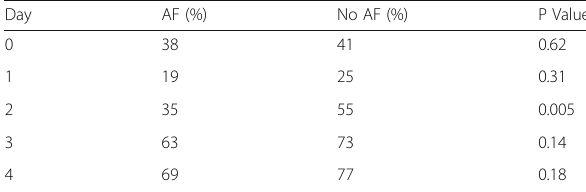
Table 1 (abstract 0197). Percentage of patients recieving Beta Blockers by